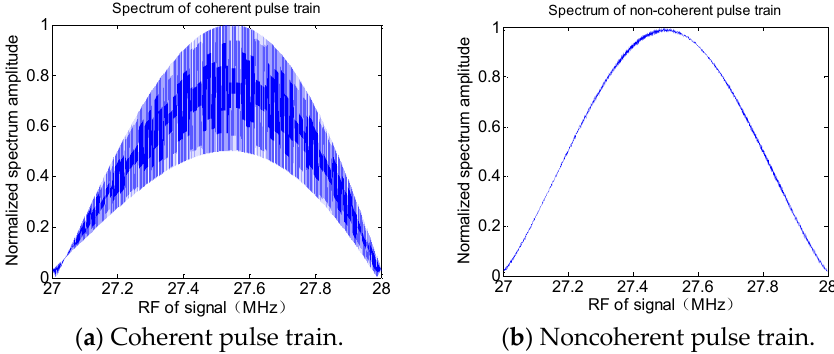
Figure 3. Spectrum image of coherent and noncoherent pulse train.